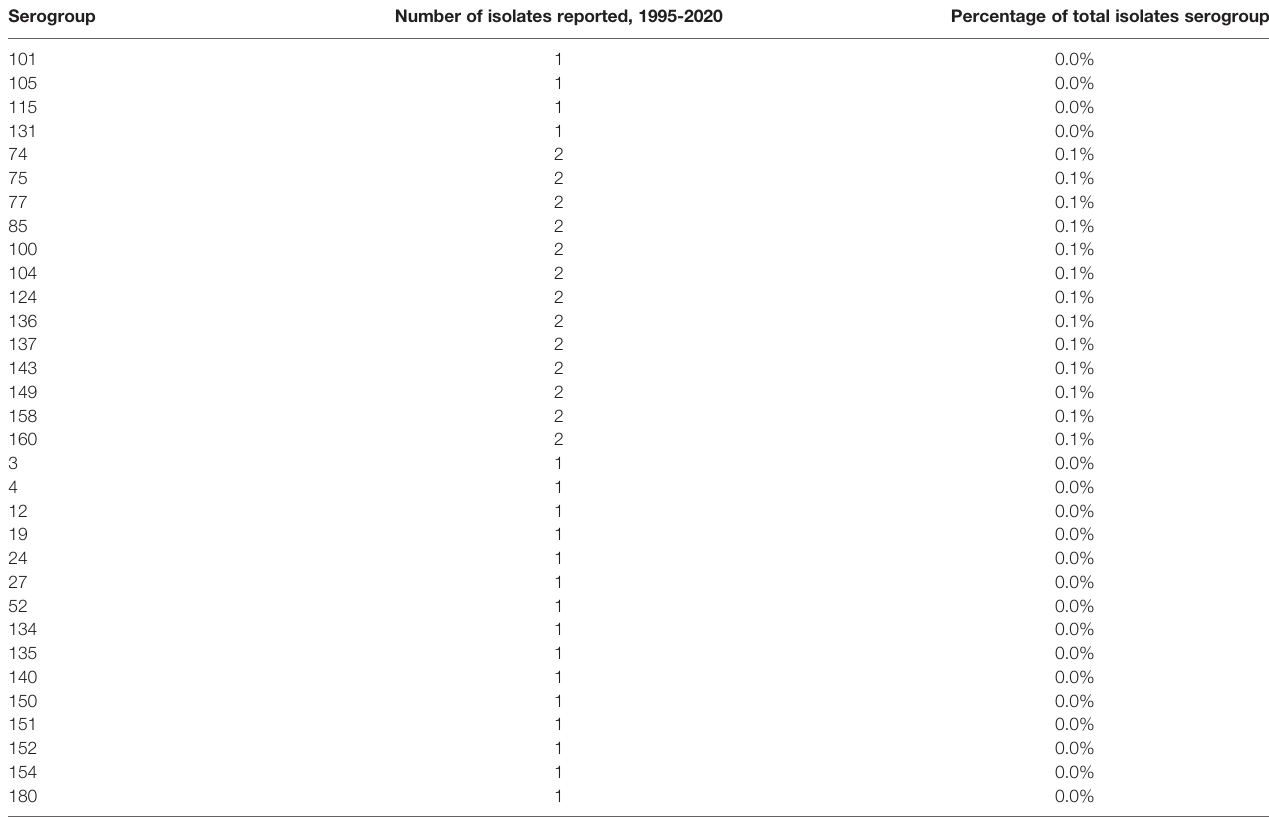
( Table 1B ) (Blankenship et al., 2020). The pathogenicity with Shigella species and STEC E. coli was almost similar but they are varied in the symptoms, metabolic traits, and severity of illness (Bommarius et al., 2013; Chou et al., 2013; Merkx-Jacques et al., 2013; Michelacci et al., 2017; Smati et al., 2017; Yun et al., 2017). The entero-aggregative STEC outbreak reported with 790 cases of HUS and 3128 non- HUS cases in Germany (May 2011) indicated a lethal HUS percentage (Cheung et al., 2011). Noval STEC strains (new serotypes) were reported for HUS cases (Bae et al., 2006). Among STEC such as O26, O45, O103, O111, O121, and O145,